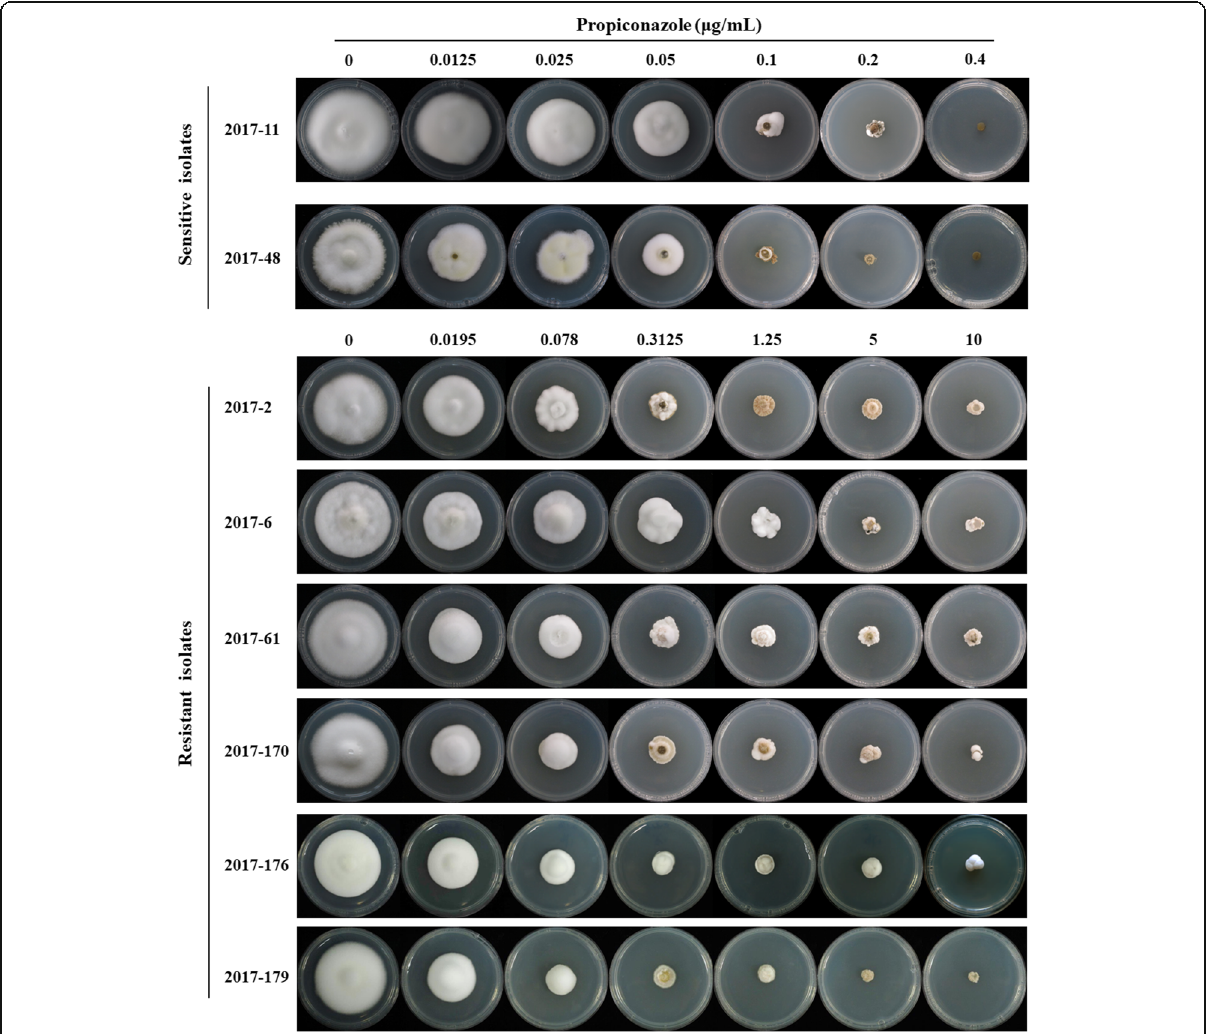
Fig. 1 Comparison of propiconazole sensitivity between propiconazole-sensitive and propiconazole-resistant U. virens isolates